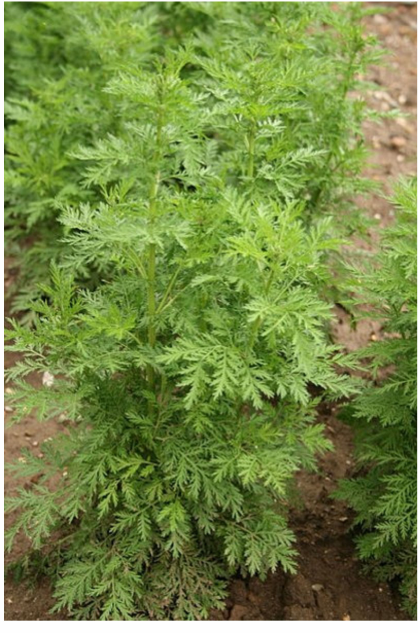
Figure 1. Crops of Artemisia annua